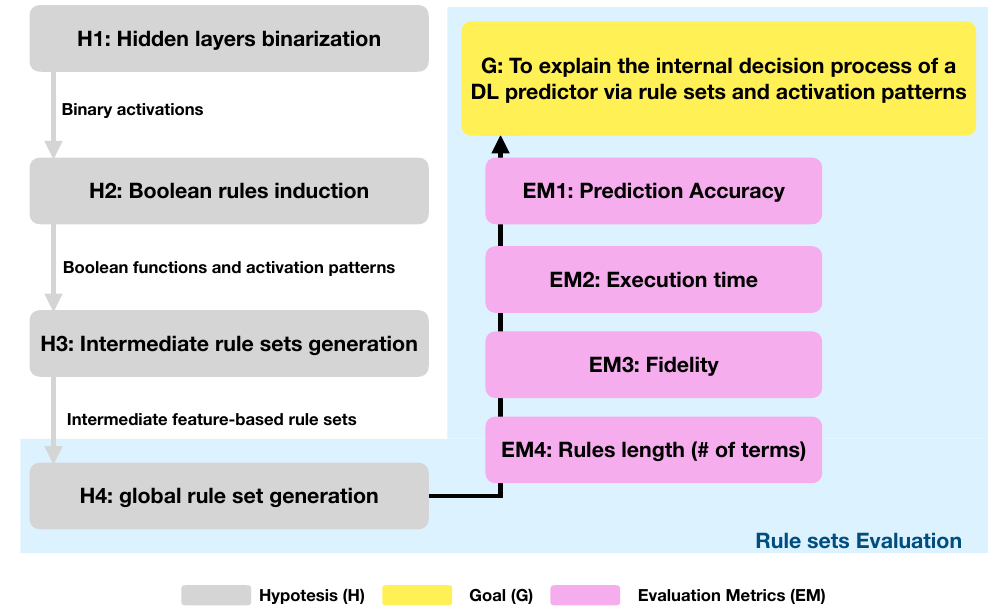
Figure 2. Overall conceptual schematization from Hypotheses (H) to the goal (G) via validation with Evaluation Metrics